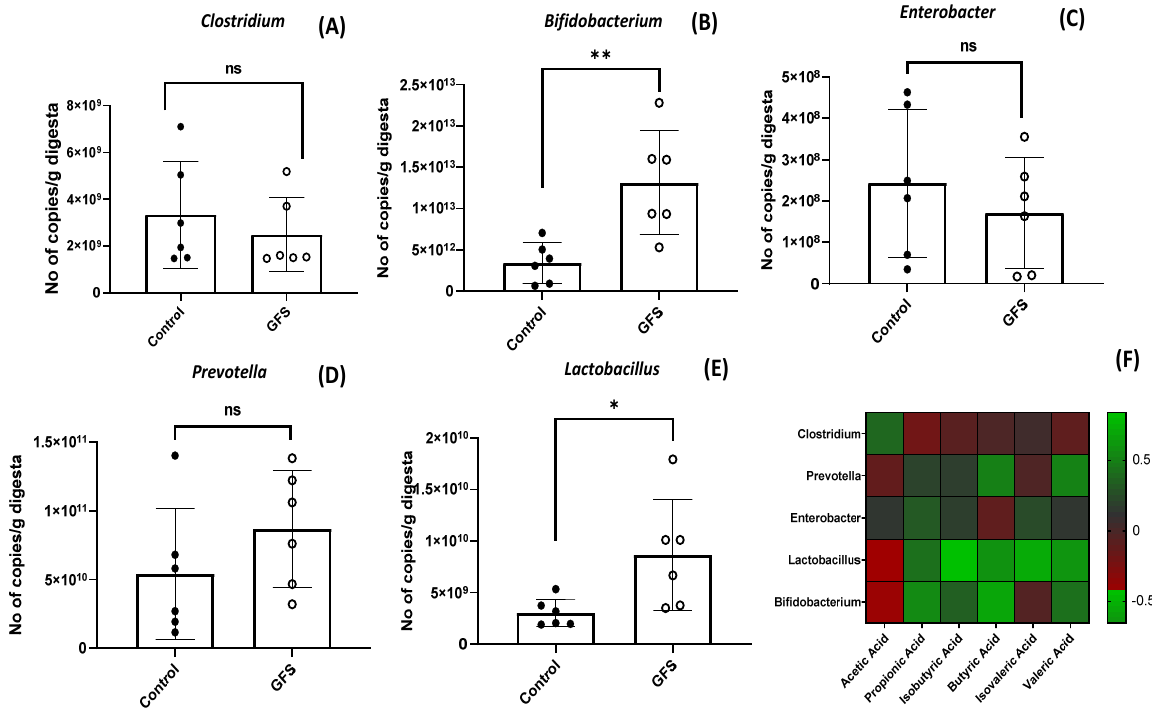
Figure 4. Effect of GFS diet on selected microbiota species and on short-chain fatty acid synthesis ( A – E ) Bacterial absolute abundances for targeted genera. ( F ) Heatmap representing Pearson’s corre- lations between SCFA concentration and genera of the microbial community in the colonic content of piglets fed a control and GFS-enriched diet (N = 12). Green indicates positive correlation; red indicates negative correlation. The results are displayed as mean ± standard error (SE). * indicates a significant difference between control and GFS-treated piglets ( p < 0.05). ** indicates a very significant difference between control and GFS-treated piglets ( p < 0.01).